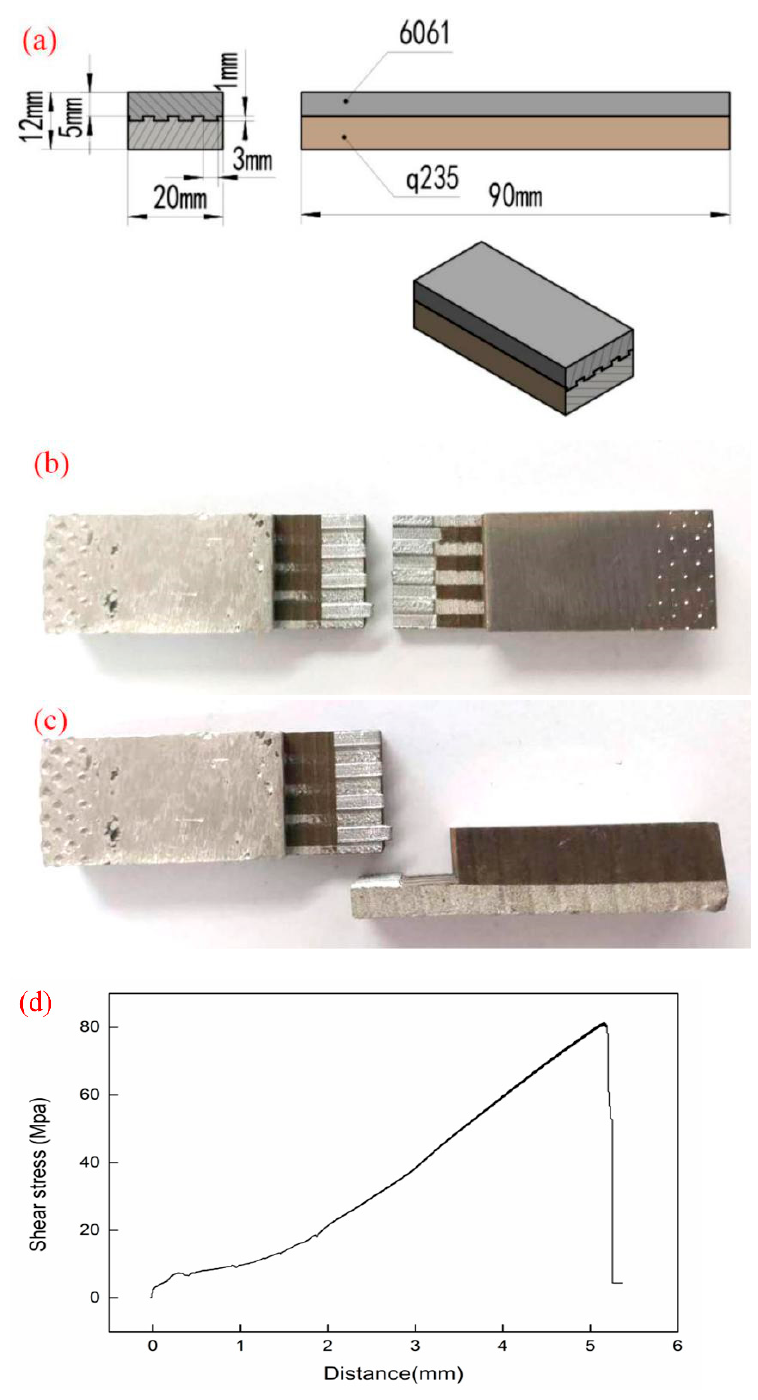
Figure 8. The sample diagrams and results of the shear force test. ( a ) The sketch diagram of shear force test sample ( b , c ) The samples of Al-6061/Q235a composite plate for the shear force test; ( d ) shear force curve of the composite plate.